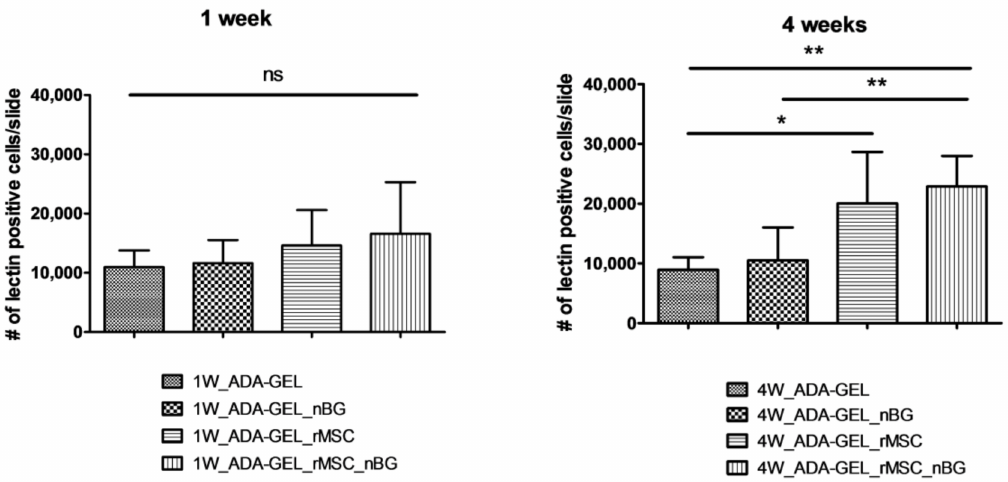
Figure 7. Quantitative evaluation/mean number (+/ − SD) of lectin-positive cells per slide. Lectin counts from slides from a previous study with the same study design without encapsulated rMSCs [18] were used for comparison. Group 4W_ADA-GEL-rMSC showed a significantly higher number than group 4W_ADA-GEL, and group 4W_ADA-GEL-rMSC-nBG exhibited a higher number of lectin-positive cells than both groups without encapsulated cells. ns: not significant; * p ≤ 0.05; ** p ≤ 0.01 (ANOVA/Bonferroni’s Post